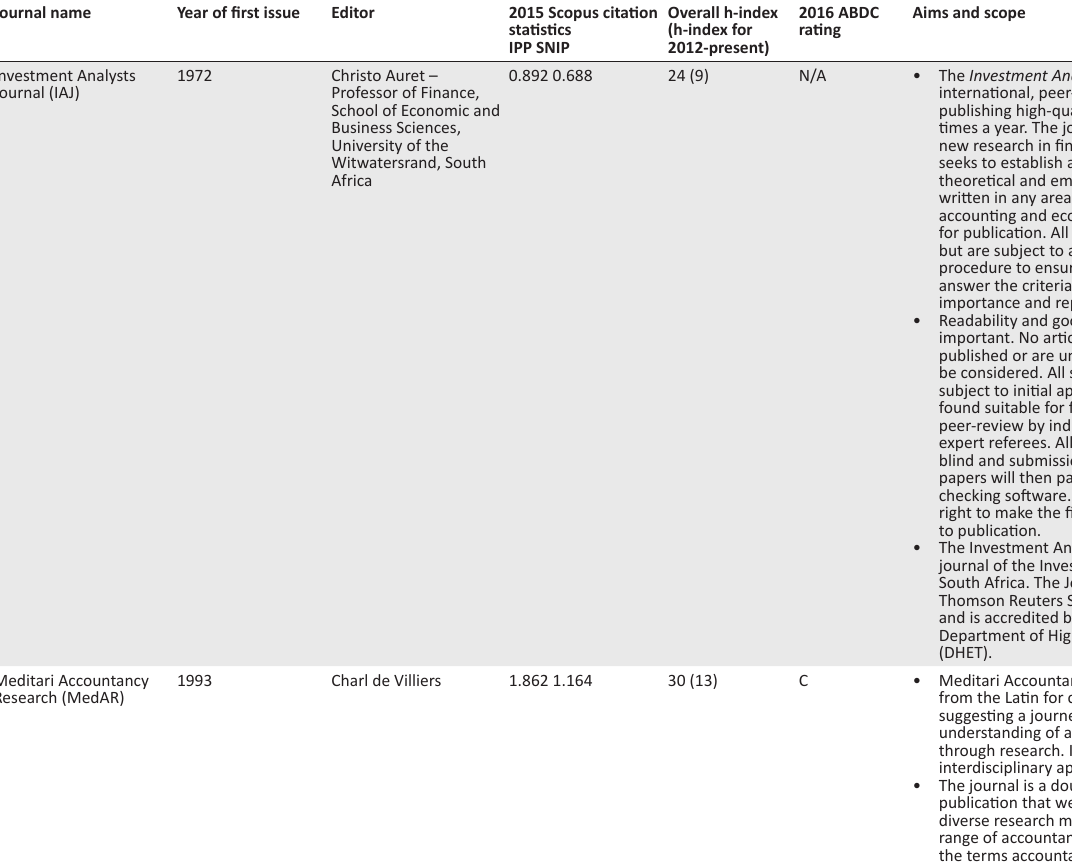
TABLE 1-A1: Journal overview for five South African accounting